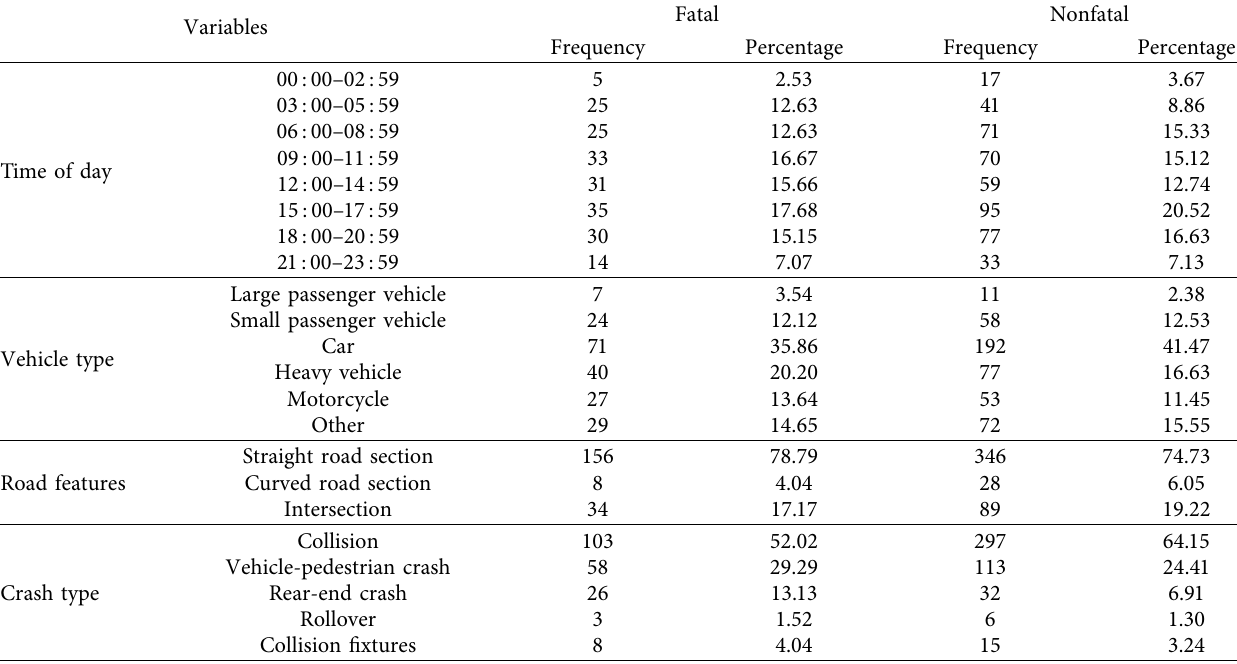
Table 2: Descriptive statistics of explanatory variables.